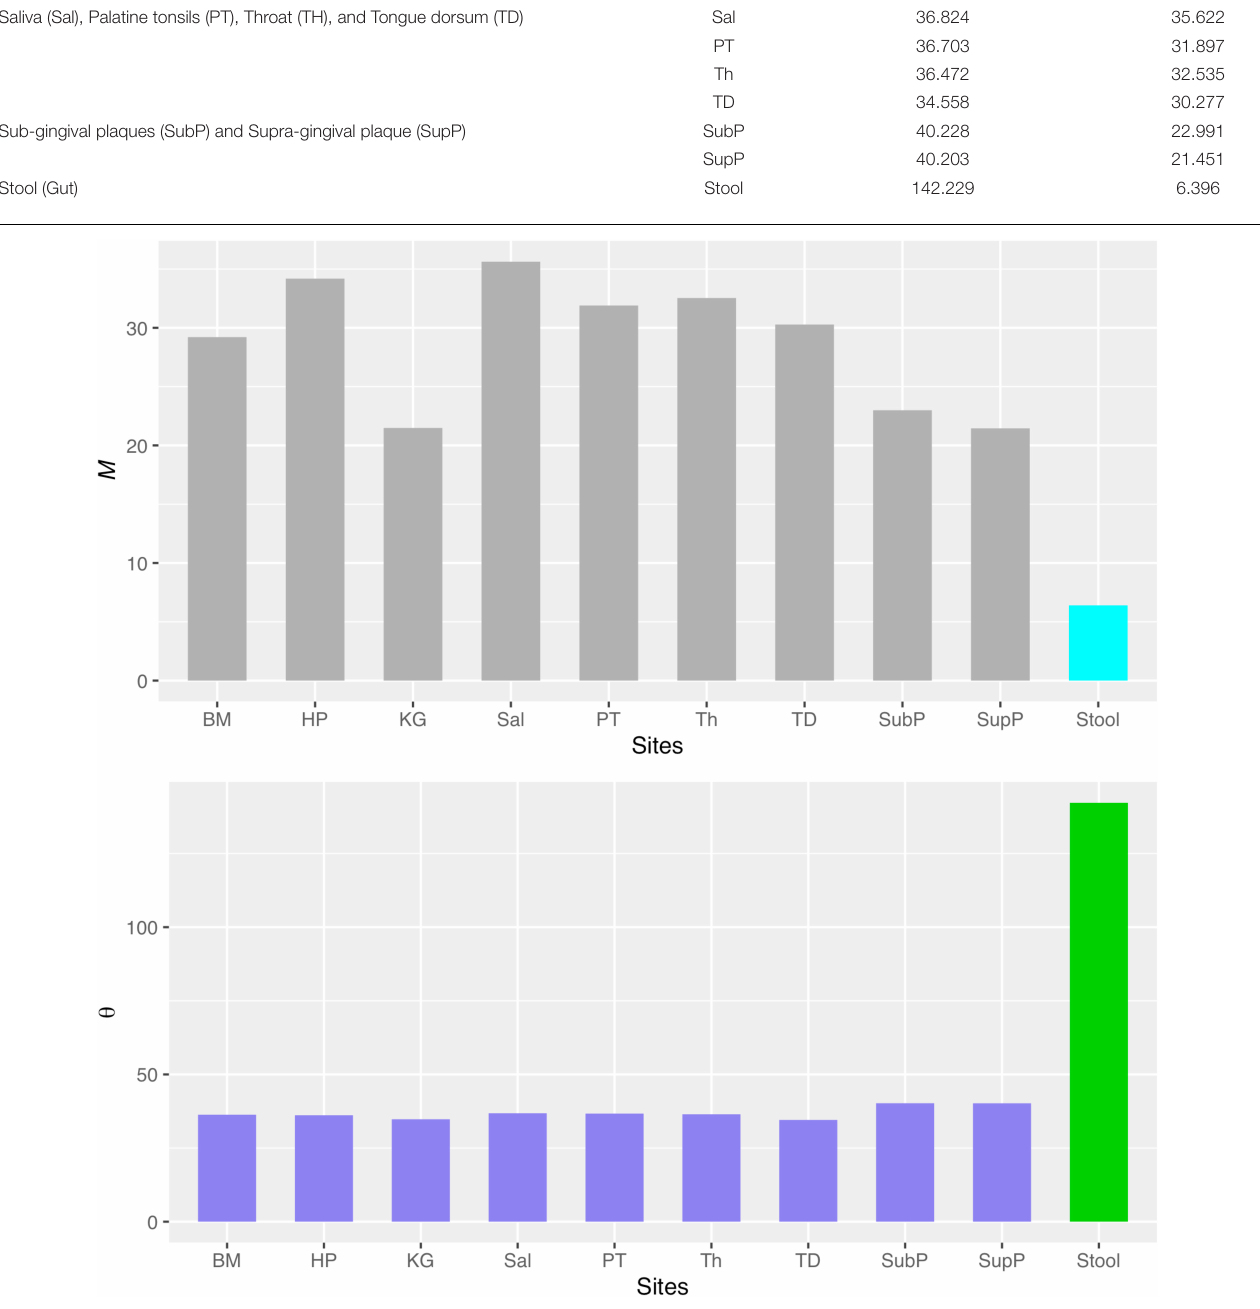
FIGURE 5 | The comparisons of migration site ( M ) and fundamental biodiversity numbers ( θ ) between oral microbiomes (the left nine sites from BM to SupP) and gut (stool) microbiome.